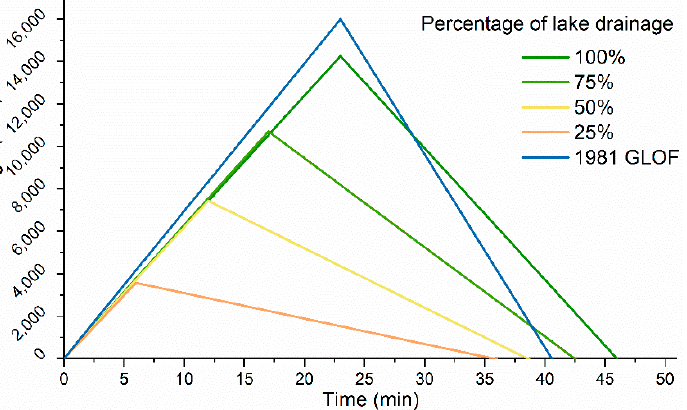
Figure 3. Breach hydrograph used as input to simulate the outburst flood at different drainage percentages. The example of Cirenmaco is presented in this figure.